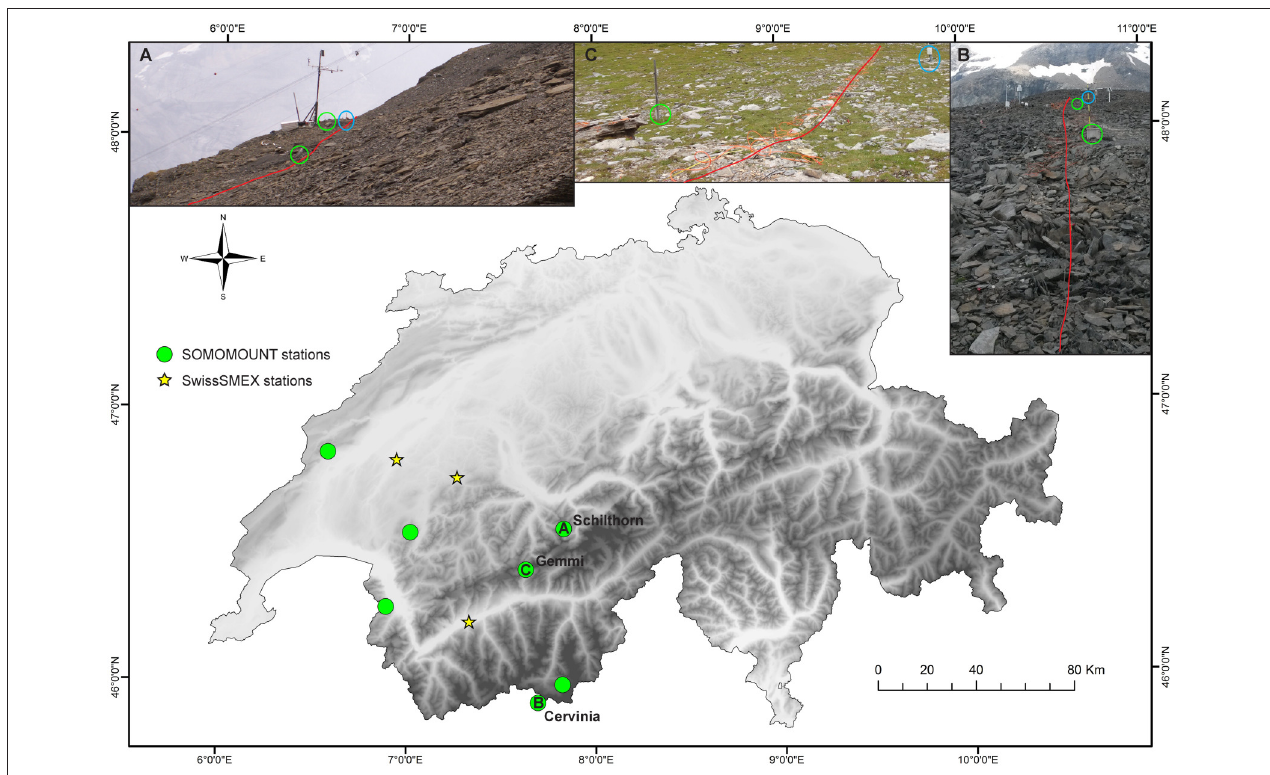
FIGURE 2 | Location of the three field sites and overview of the geophysical profiles (red lines), borehole locations (green), and soil moisture monitoring stations (blue) at (A) Schilthorn, (B) Cervinia, and (C) Gemmi. The digital elevation model was obtained from Bundesamt für Landestopografie swisstopo.